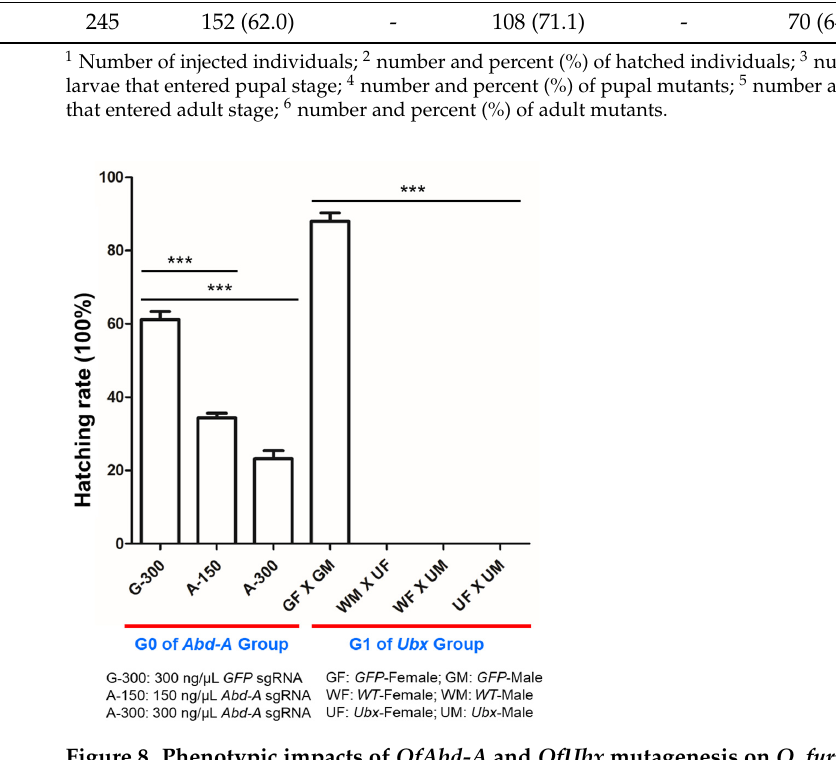
Figure 8. Phenotypic impacts of OfAbd-A and OfUbx mutagenesis on O. furnacalis hatching rate. Knocking out of OfAbd-A resulted in embryonic lethality, while OfUbx mutation led to adult sterility. From left to right, bars depict the hatching rates of eggs injected with different concentrations of OfAbd-A sgRNA, and the hatching rates of eggs produced by adult OfUbx mutants mated with each other. The asterisks (***) indicate significant differences ( p < 0.01 or p < 0.001), compared to results from wild-type adults with a two-tailed t